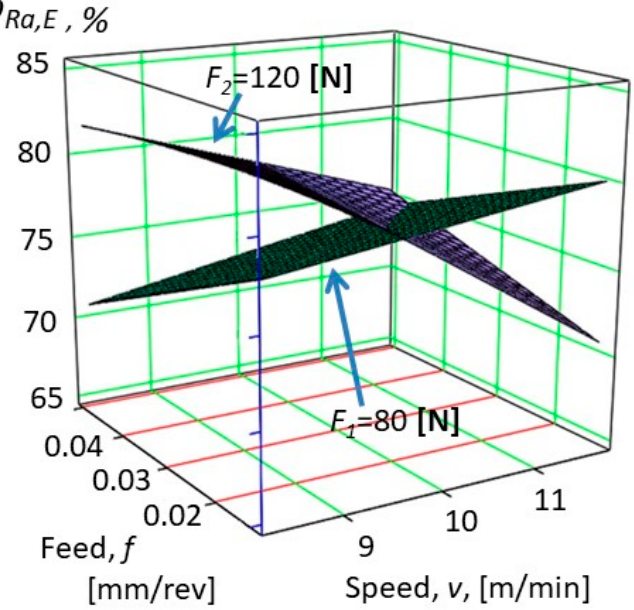
Figure 9. Improvement of the change of surface roughness ρ Ra , E on specimens marked E (see Equation (7)).